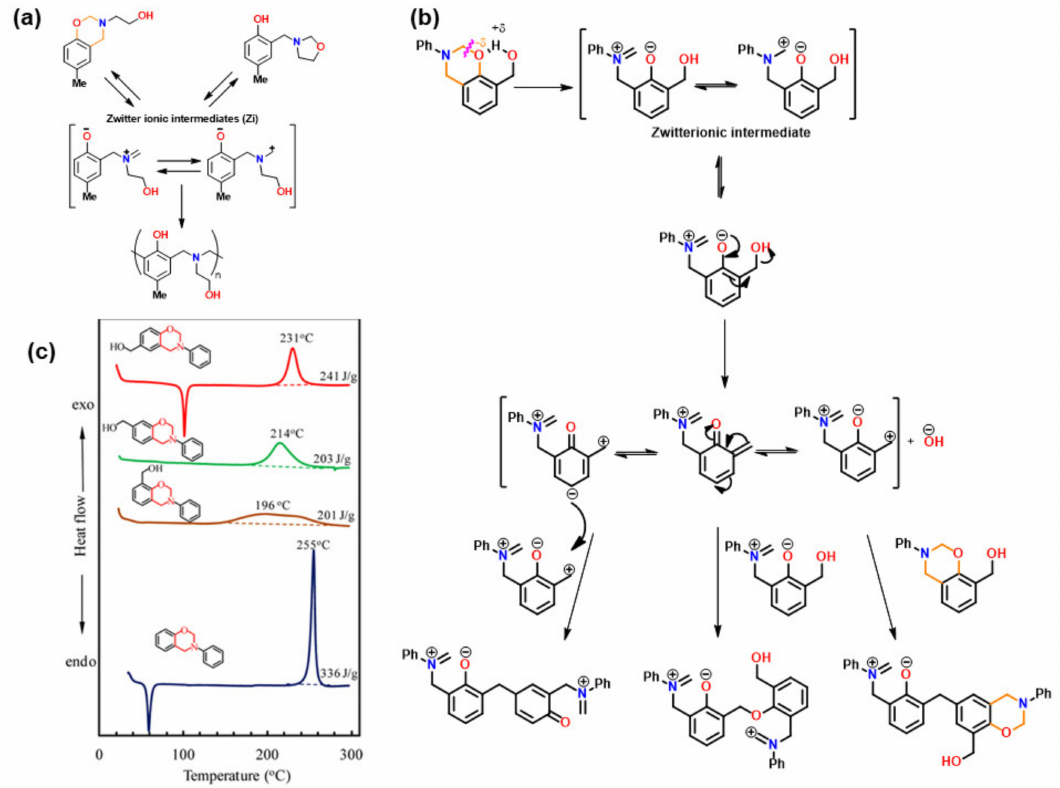
Figure 67. Acceleration mechanism of oxazine polymerization by the neighboring group effect. Variation in mode of polymerization of benzoxazine monomer with substitutions: ( a ) 2-hydroxyethyl [189] and ( b ) 2-hydroxymethyl group [403]. ( c ) DSC thermogram of benzoxazine monomers with and without methylol functionality [403]. Copyright 2012. Reproduced with permission from American Chemical